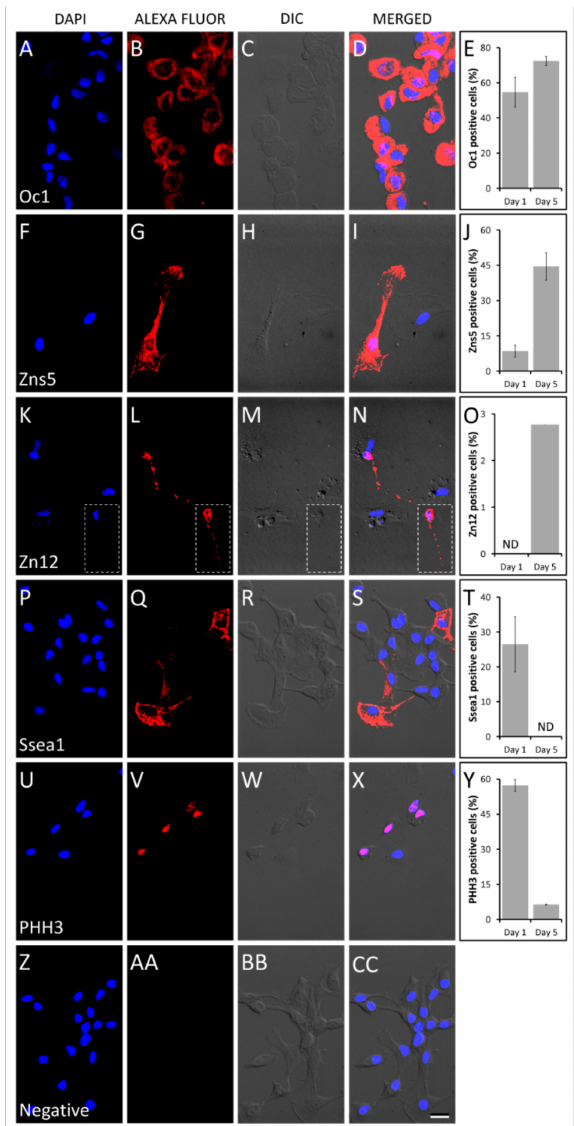
Figure 3. Di ff erentiation of zebrafish blastema cells confirmed by immunofluorescence labeling at day 5 (except for Ssea1 at day 1). Zebrafish blastema cells immunolabeled with the osteoblast marker Osteocalcin 1 / Oc1 ( A – D ), the scleroblast marker Zns5 ( F – I ), the neuronal cell surface marker Zn12 ( K – N ; inserts illustrate a neuron-like cell), the stage-specific embryonic antigen Ssea1 ( P – S ), and the proliferation marker PHH3 ( U – X ). For each marker, picture sequence is as follows: DAPI labeling, ALEXA Fluor 594 labeling, di ff erential interference contrast (DIC) image and merge image; percentages of cells positive for each marker at days 1 and 5 of cell culture were determined from manual counting and are presented as mean ± standard deviation calculated from three di ff erent coverslips ( E , J , O , T , Y ). Negative control ( Z – CC ). ND, not detected. Scale bar is 10 µ